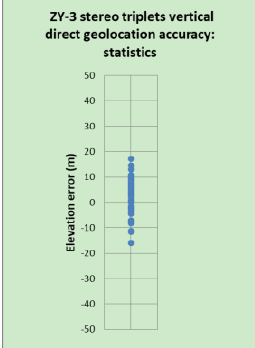
Figure 7. ZY-3 stereo triplets vertical direct geolocation accuracy (statistics). Num=47 stereo triplets; Average=1.572m; RMS=7.518m.